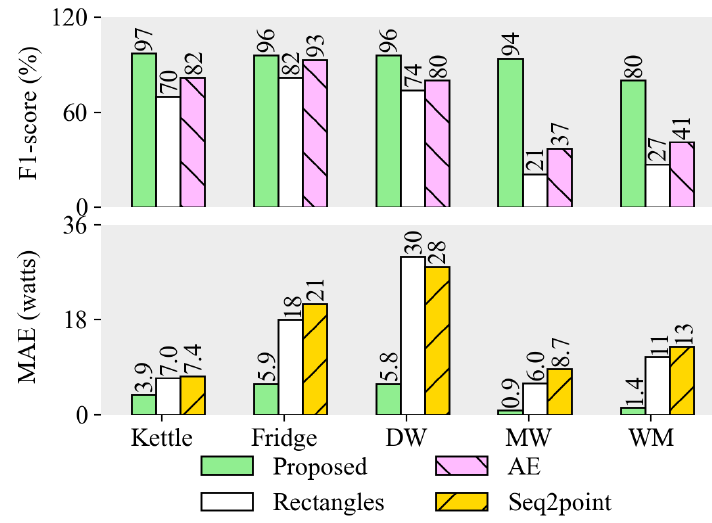
Figure 9. Energy disaggregation results on the UK-DALE dataset.